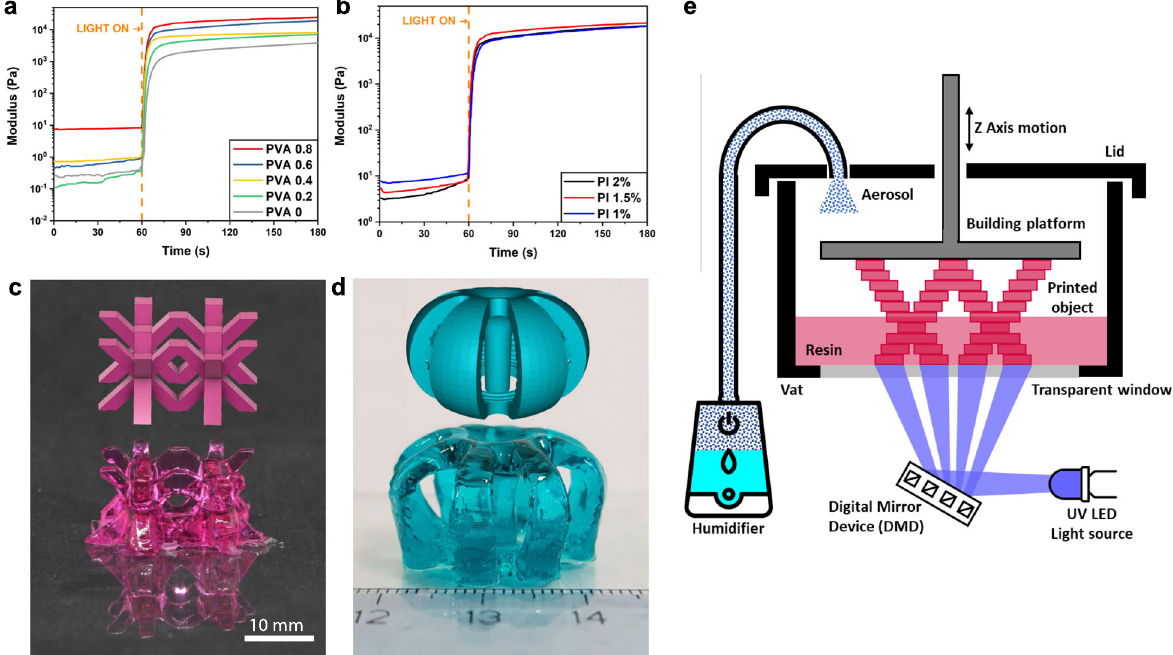
Fig. 2 Layer-by-layer fabrication. a Real-time photorheology of formulations with different PVA/AAc ratios under constant shear frequency (10 rad/s) and constant strain amplitude (1%). b Real-time photorheology of the formulation with a PVA/AAc ratio of 0.8 (PVA 0.8) with different photoinitiator concentrations under constant shear frequency (10 rad/s) and constant strain amplitude (1%). c , d 3D fabricated samples with PVA 0.8 formulation: c ) Body-centered cubic lattice-like structure printed with methyl red sodium salt dye. d Axisymmetric structure with central pillar printed with brilliant green dye. e Schematic overview of the Digital Light Processing (DLP) printing apparatus used in this